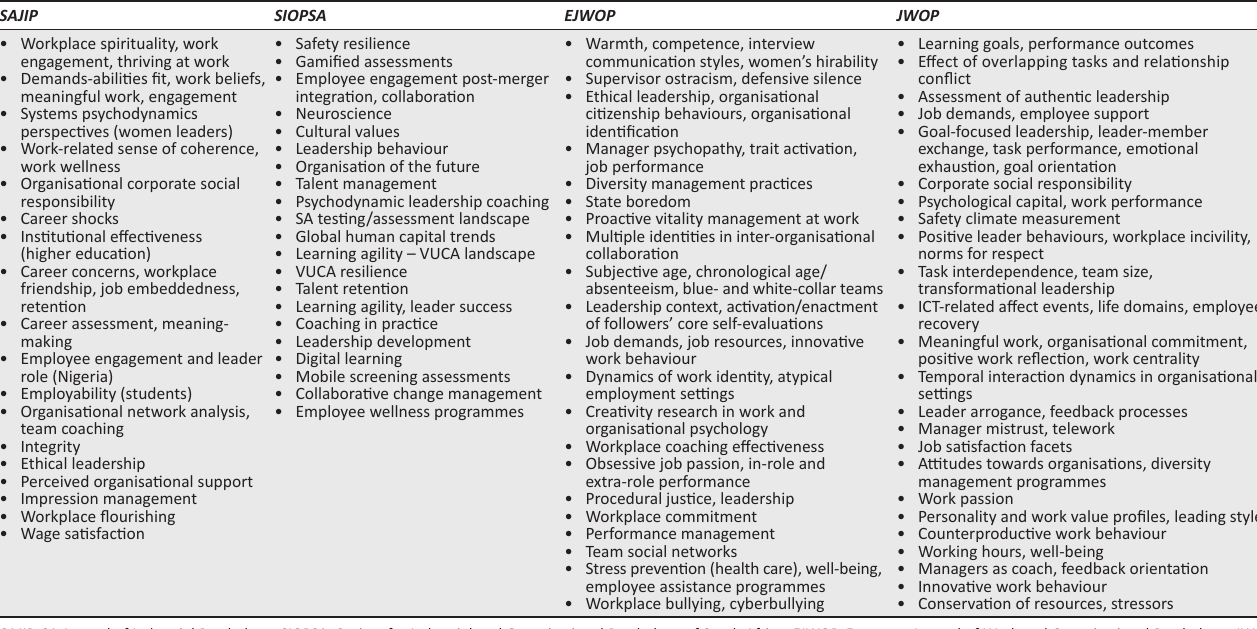
TABLE 1: Overview of article topics: